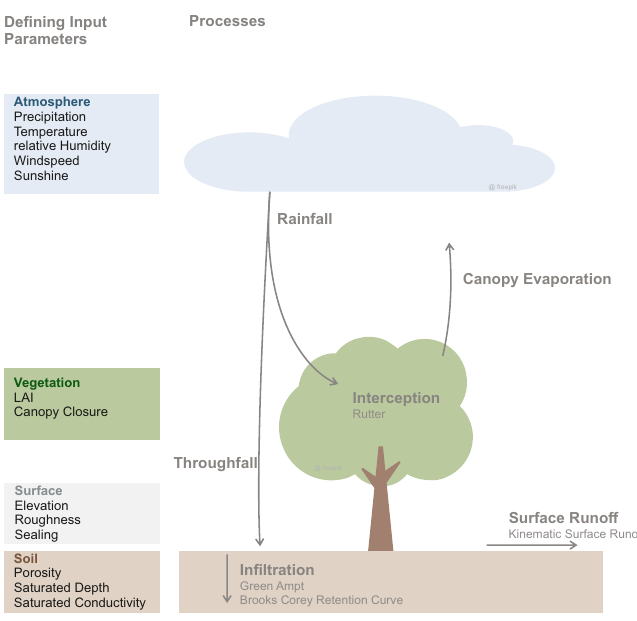
Figure 2. Used processes and defining parameters of storages in